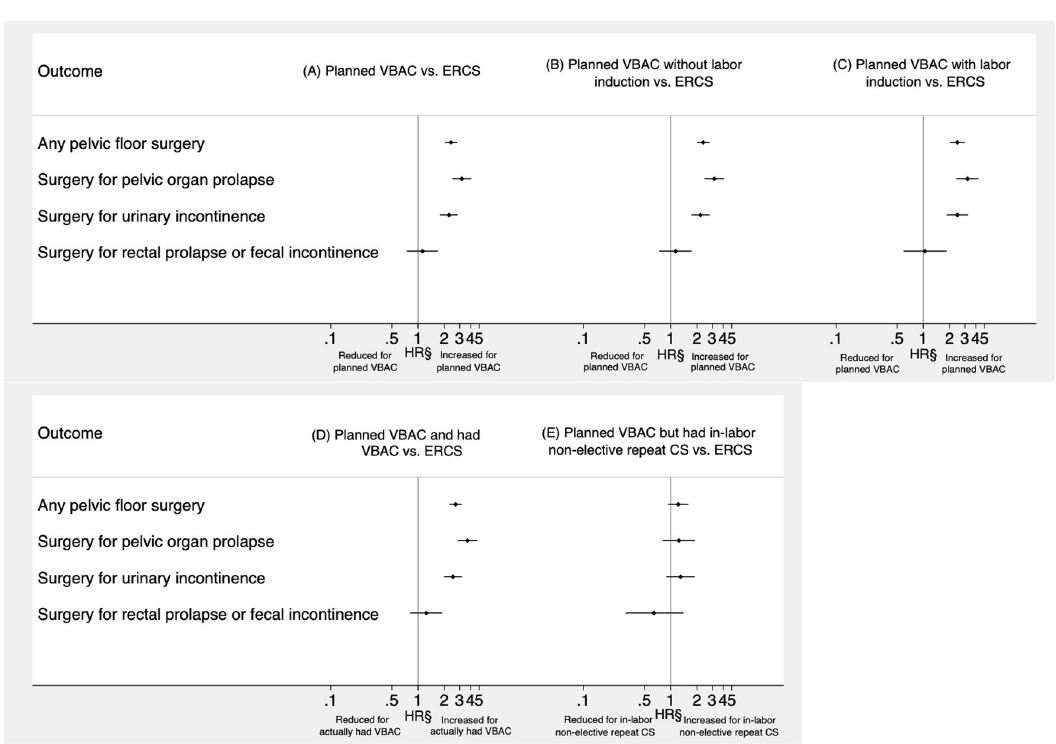
Fig 3. Outcomes following (A) planned VBAC compared to ERCS (B) planned VBAC without labor induction compared to ERCS (C) planned VBAC with labor inuction compared to ERCS (D) planned and actually had VBAC compared to ERCS, (E) planned VBAC but had in-labor non-elective repeat cesarean section compared to ERCS. § Adjusted for year of birth and sociodemographic factors (maternal age, mother’s country of birth, marital status, and area deprivation) and maternal medical and obstetric-related factors (previous mode(s) of birth—categorized as cesarean section only/cesarean section and vaginal birth(s), parity, interpregnancy interval, diabetes, birth weight of child in pregnancy/birth in question treated as a continuous variable). CS, cesarean section; ERCS, elective repeat cesarean section; HR, hazard ratio; VBAC, vaginal birth after previous